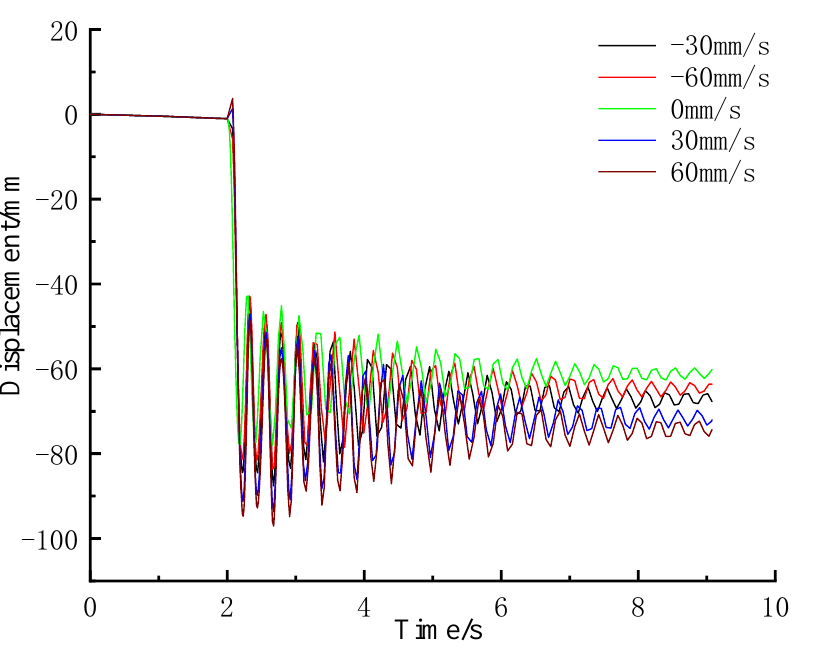
Figure 2. Effect of the initial velocity.